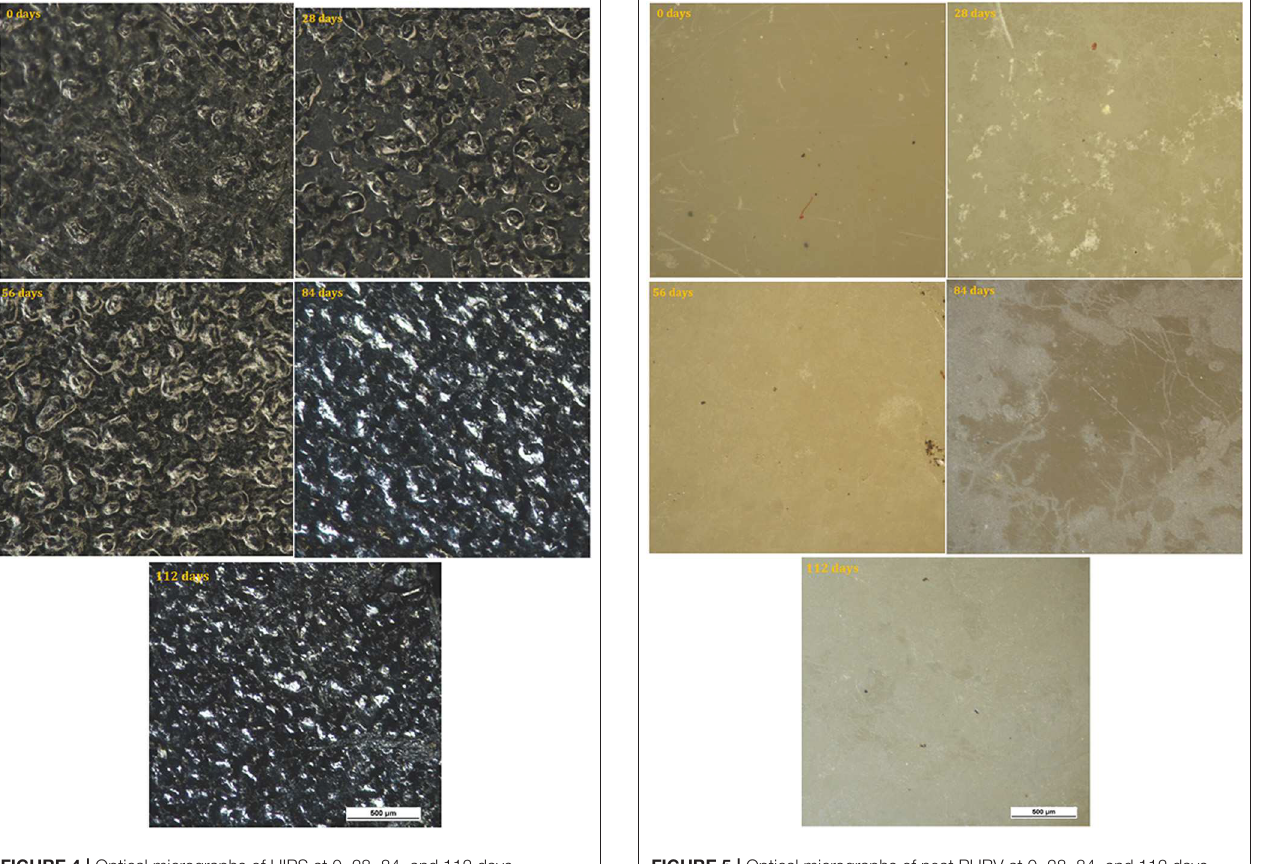
FIGURE 4 | Optical micrographs of HIPS at 0, 28, 84, and 112 days. FIGURE 5 | Optical micrographs of neat PHBV at 0, 28, 84, and 112